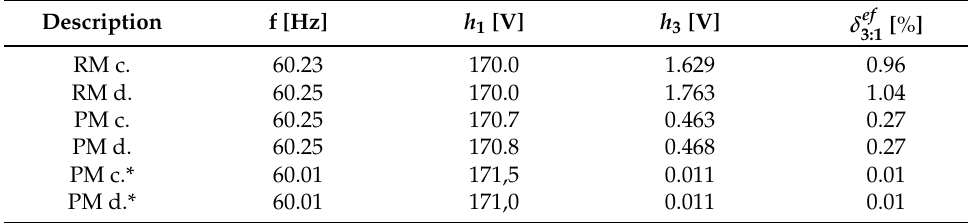
Table 7. RL load 50% of nominal, (*) using C osc and L osc from